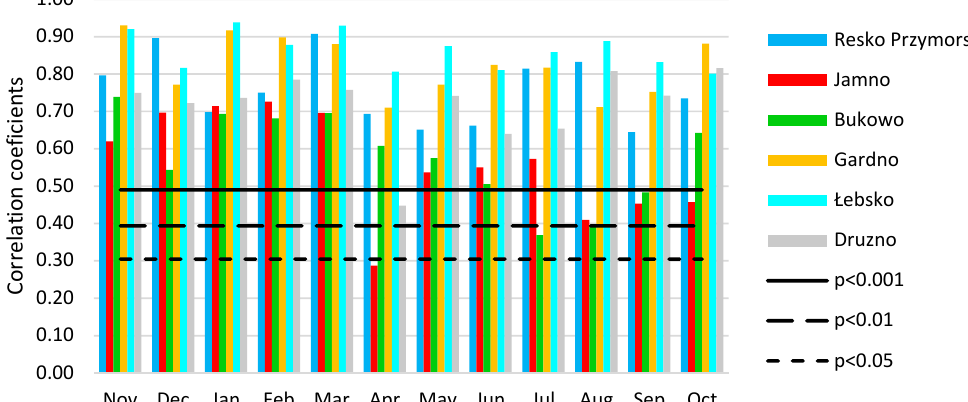
Figure 4. Coefficients of correlation of maximum water levels in the analyzed lakes and in the Baltic Sea and their levels of significance.